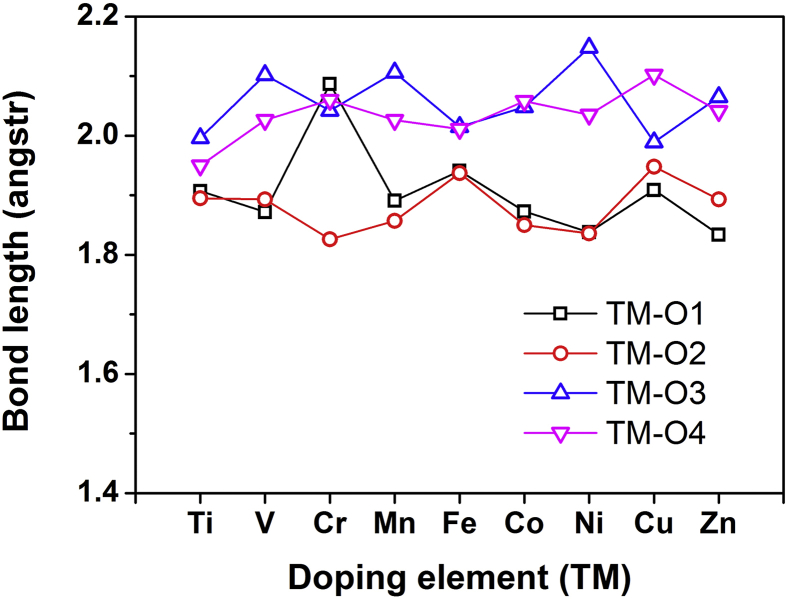
Main bond lengths for TMO5 bipyramids in hexagonal YMn0.917TM0.083O3 bulks dependence on doping elements (TM) from Ti to Zn.